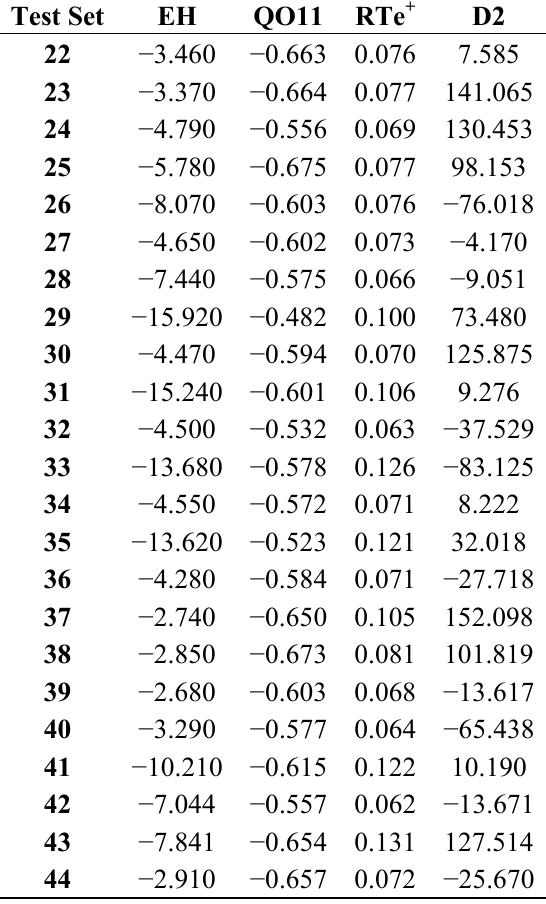
Table 6. Molecular properties selected by analysis of main components of test set with antimalarial activity